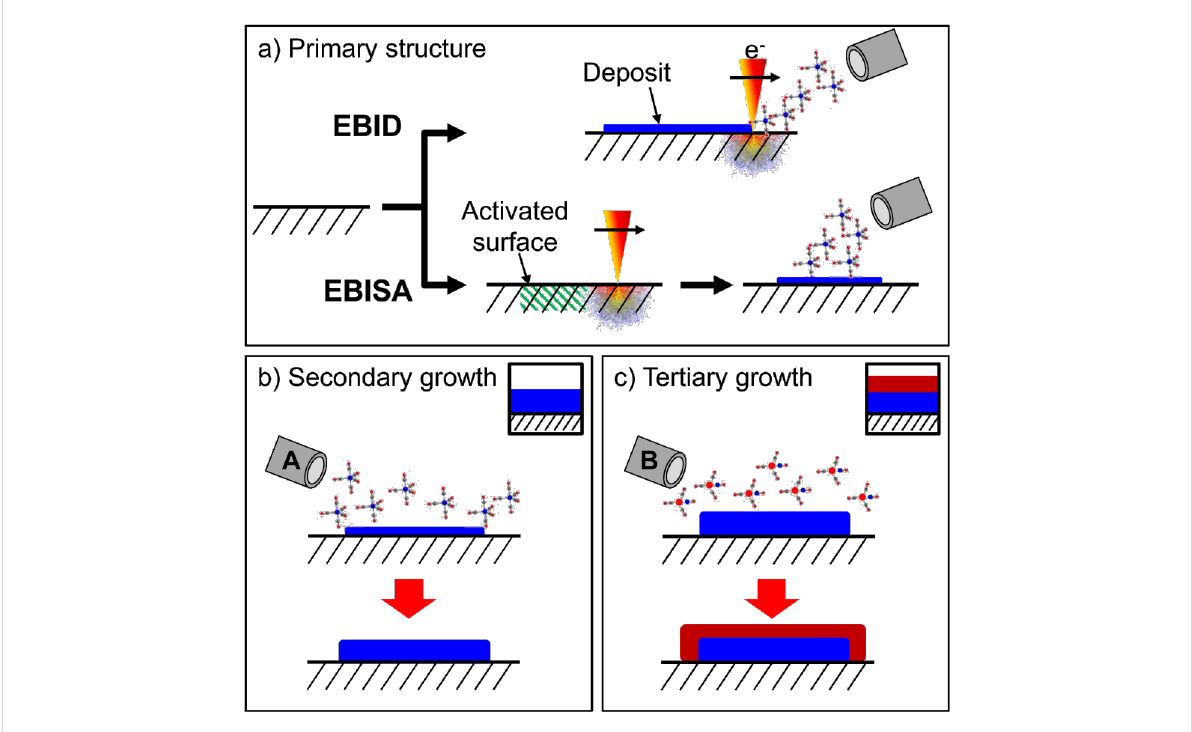
Figure 1: Fabrication and secondary/tertiary growth of nanostructures. The deposits can be fabricated by electron irradiation of a surface in the pres- ence of a precursor (EBID) to form a thin primary deposit (a, top). In the absence of a precursor (a, bottom), some surfaces can undergo selective electron-beam induced surface activation (EBISA), also yielding a primary deposit upon post-exposure to the precursor. If the primary deposits are exposed to the precursor in a successive step, autocatalytic decomposition can lead to further secondary autocatalytic growth of the deposit (b). In the case that a second, different precursor is supplied, another autocatalytic growth process (tertiary growth) can occur, leading to the formation of a layered nanostructure (c). The icons in b) and c) will be used to indicate the respective process throughout this